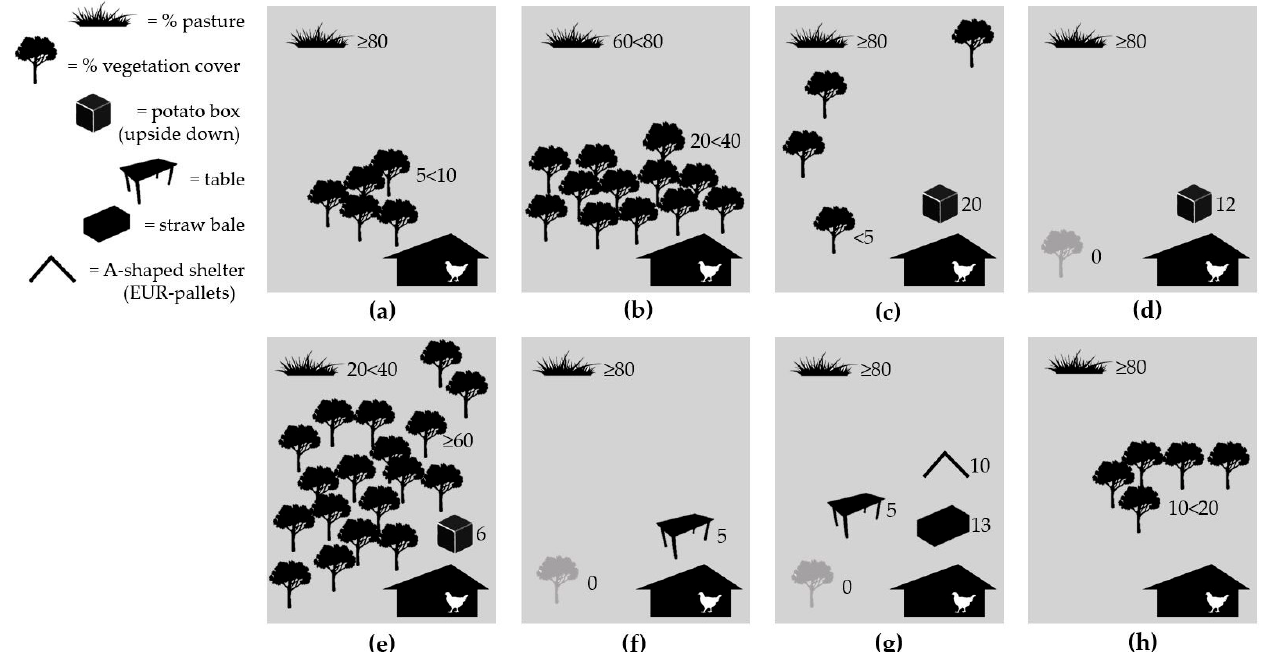
Figure 5. Schematic illustrations (note: not to scale) of vegetation dispersion and artificial shelters (AS) in free-range areas on organic broiler farms ( n = 8) in Sweden: ( a ) one single distinct area with trees and bushes within 55 m from winter garden; ( b ) population of trees and bushes without clear boundary within 65 m from veranda; ( c ) six distinct areas (single trees and occasional bushes) distributed throughout the free-range. Total AS overhead cover area 24.6 m 2 ; ( d ) pasture only. Total AS overhead cover area 14.4 m 2 ; ( e ) trees and bushes distributed throughout the range (difficult to get a clear view of the entire range). Total AS overhead cover area 7.5 m 2 ; ( f ) pasture only. Total AS overhead cover area 15 m 2 ; ( g ) pasture only. Total AS overhead cover area 28.2 m 2 ; ( h ) one single distinct area with trees and bushes within approximately 50 m from house. Table 6. Proportion of broiler flocks observed free-ranging (FR) on Swedish organic chicken farms ( n = 8), distance from winter garden and prevailing weather conditions (HR: heavy rain; D: drizzle; S: sunny; C: cloudy). Distance (m) from Winter Garden (% of FR Chickens) Maximum Temperature Distance (m) from Farm Proportion % ( ◦ of Flock FR 1 Winter Garden